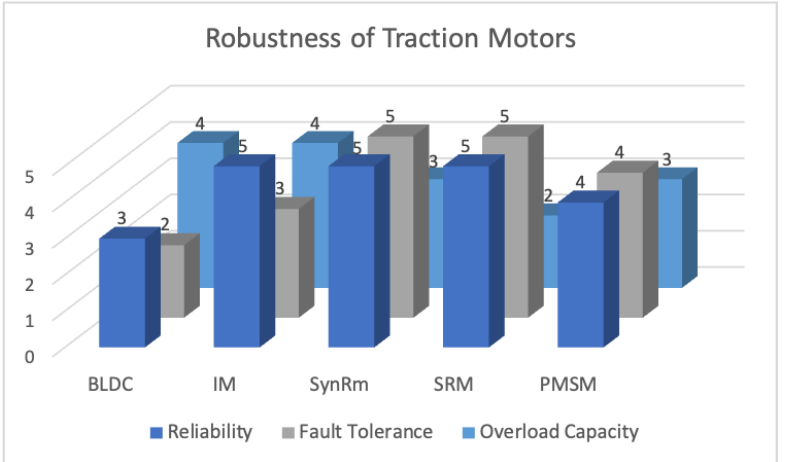
Figure 15. Reliability, stress tolerance and overload capacity scoring for the five selected powertrains.